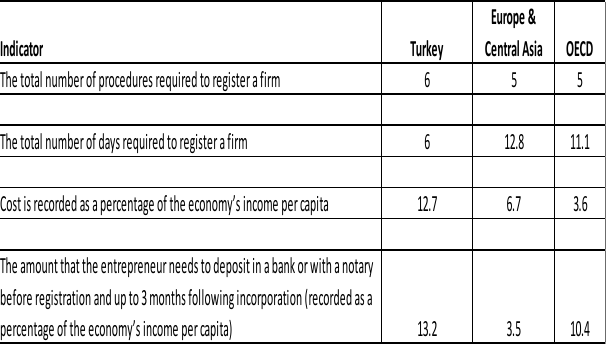
Source : World Bank Doing Business Report